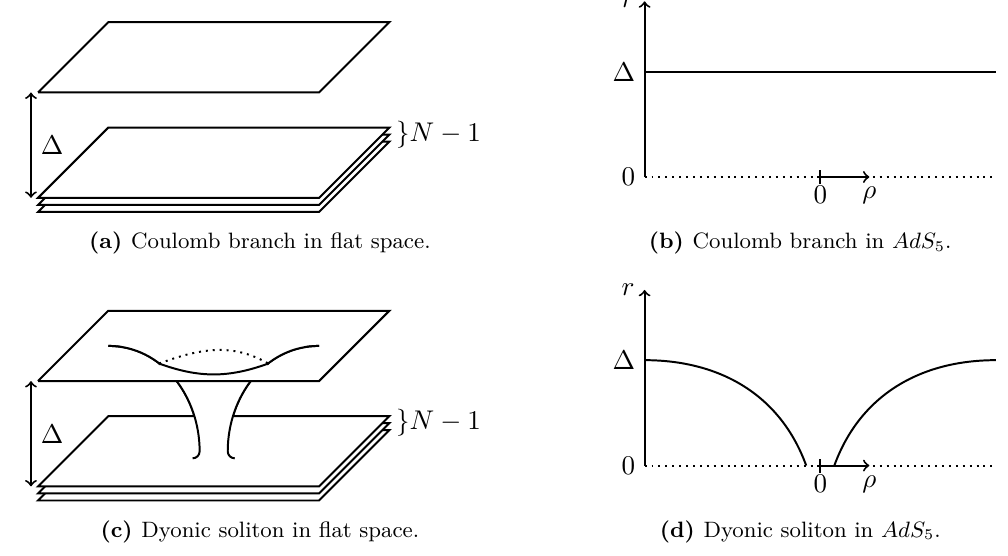
Figure 1. Cartoons of the D3-brane configurations discussed in this